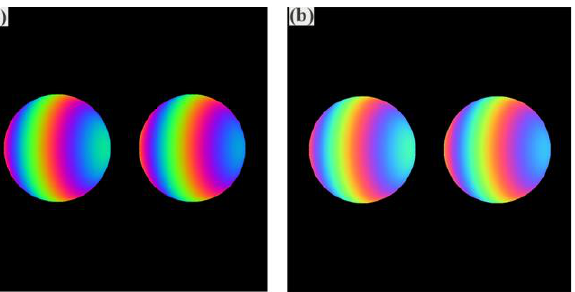
Figure 3. Spheres deformed by ( a ) the ideal pattern and ( b ) the distorted pattern.